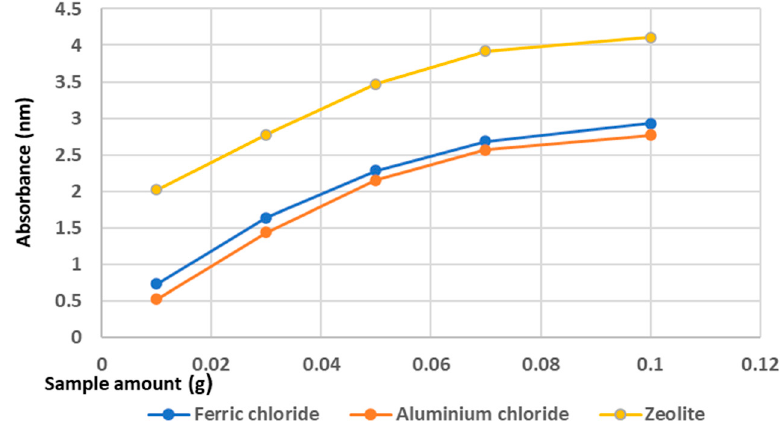
Figure 8. Comparison of different method (coagulation agents vs adsorption on composite materials) on phosphorus removal performance from wastewater.